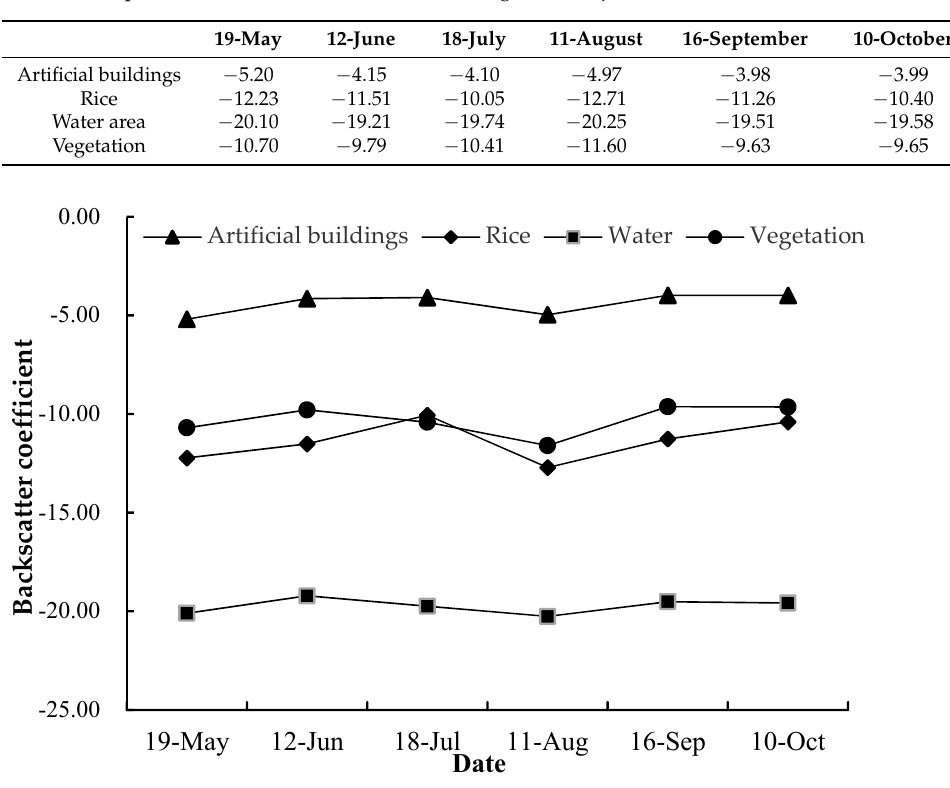
Figure 16. Sentinel-1 VH polarization backscatter coefficient of ground objects.